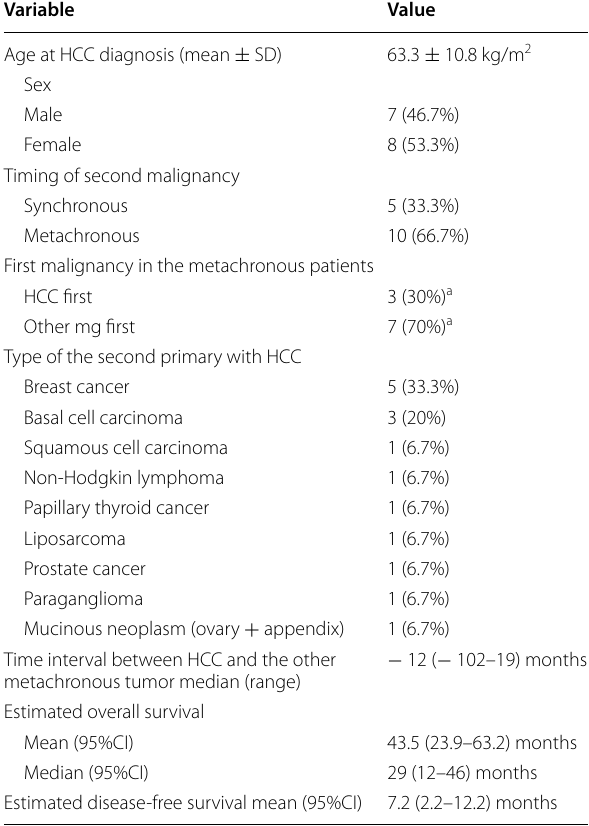
Table 1 Epidemiologic criteria of the studied group and the survival of the